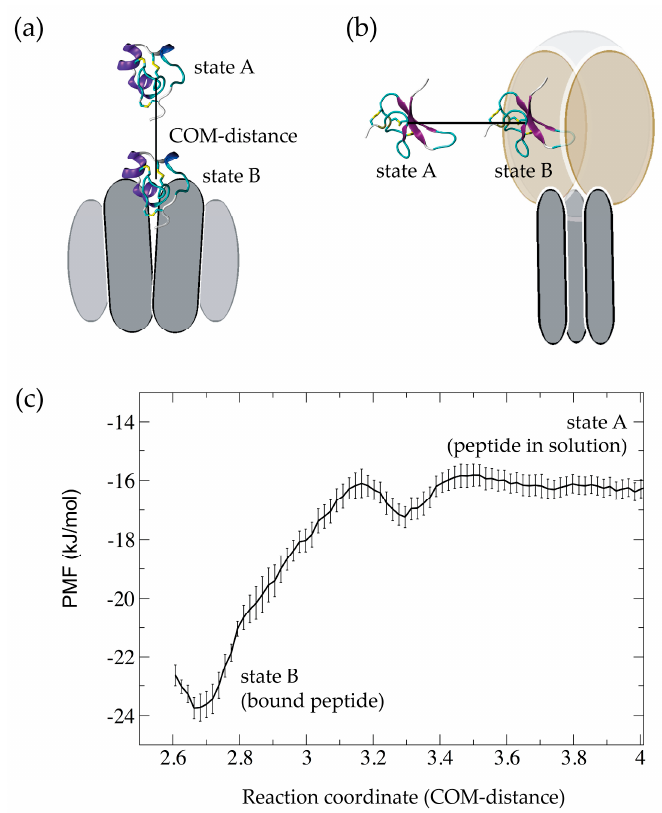
Figure 3. Free energy calculations from umbrella sampling simulations. ( a , b ) Schematic of a one-dimensional reaction path that connects the peptide in solution (state A) to the peptide bound to a protein (state B). The reaction coordinate is the centre of mass (COM) distance between the peptide and the protein; ( c ) Example of a potential of mean force (PMF) obtained from umbrella sampling simulations that shows the free energy as a function of the reaction coordinate.